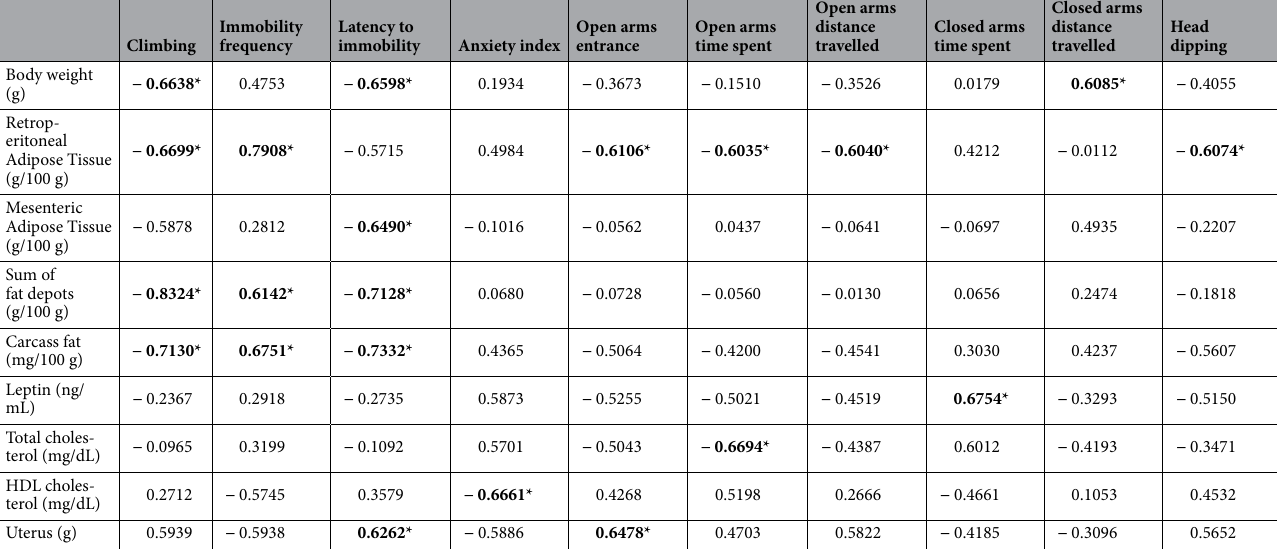
Table 2. Pearson’s correlations coefficients of the Sham, Sham + GbE, OVX and OVX + GbE groups. Pearson’s correlations between body/serum parameters and behavioural variables; n = 40; *p < 0.05 (two-tailed).